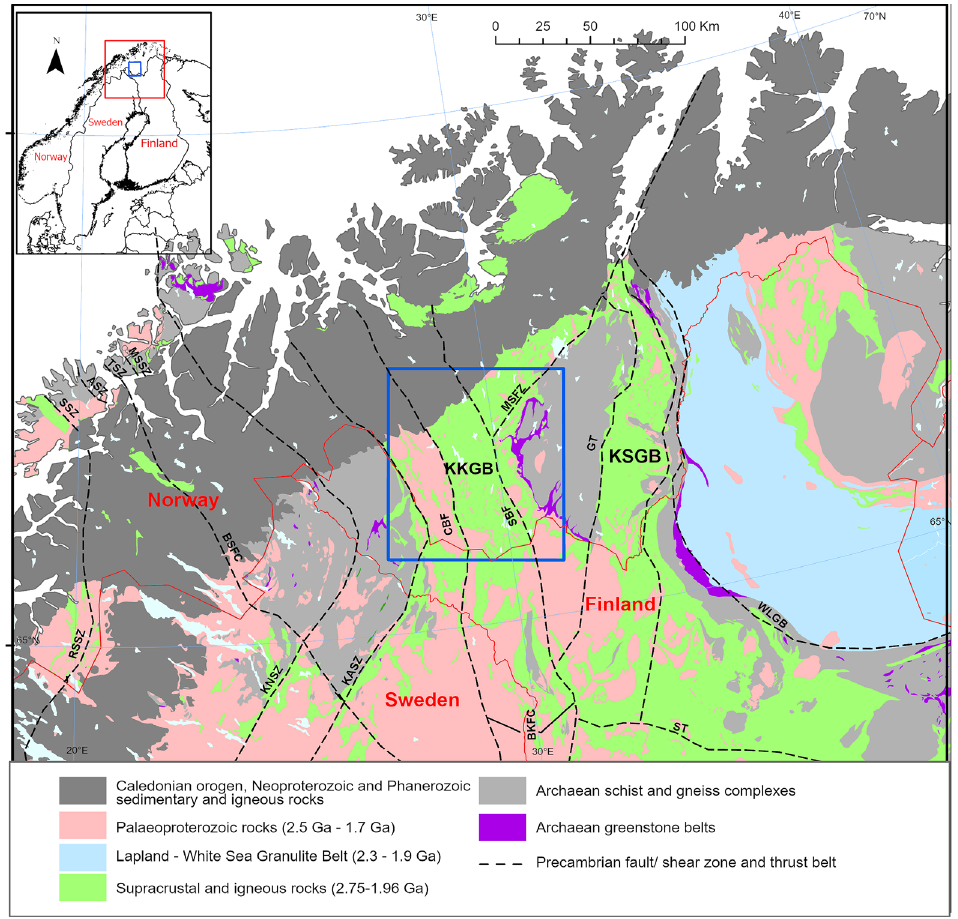
Figure 1. Tectonic map of northern Scandinavia (modified after Koistinen et al., 2001 )and the main structural trends of Palaeoproterozoicand Archaean basement areas in northern Finland, Norway and Sweden. The study area for the 3D model is shown by the blue box. ASZ: Astridal Shear Zone; BKFC: Botnian–Kvænangen Fault Complex; BSFC: Bothnian–Senja Fault Complex; CBF: Čiekŋaljohka–Boaganjávri Fault; GT: Guvvajávri thrust; KASZ: